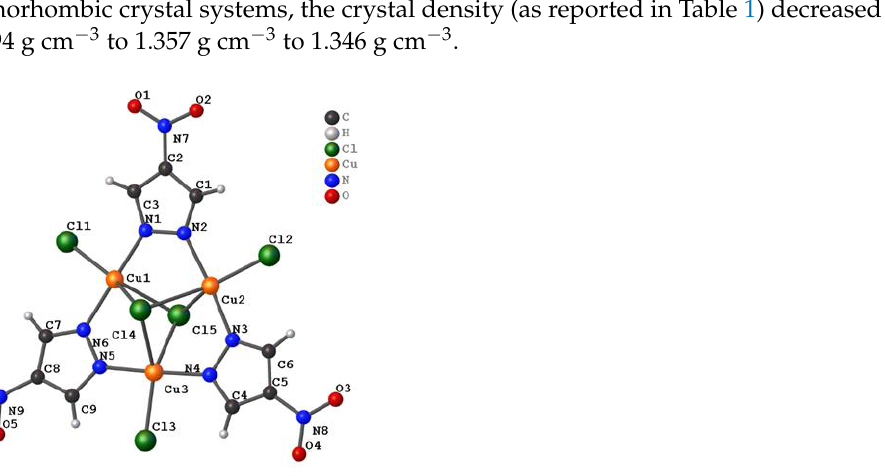
Figure 1. Representative structure and atom numbering scheme of the [Cu 3 (μ 3 -Cl) 2 (μ -4-NO 2 - pz) 3 Cl 3 ] 2- unit for 1 ( a – c ). Table 2. Selected bond lengths (Å ) for 1a – 1c .